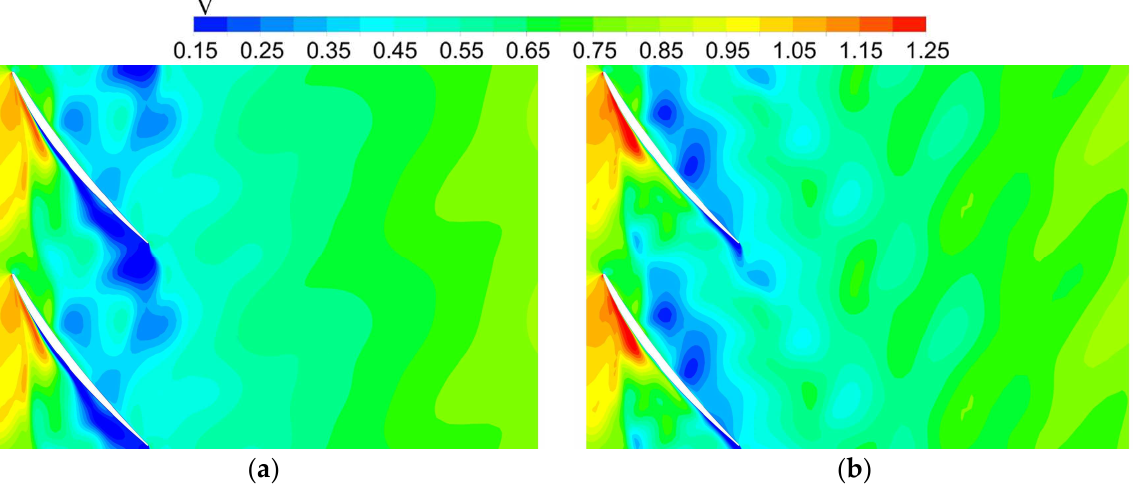
Figure 22. Distribution of transient normalized relative velocity at 99% span. ( a ) Re = 1 × 10 5 ; ( b ) Re = 4 × 10 5 .